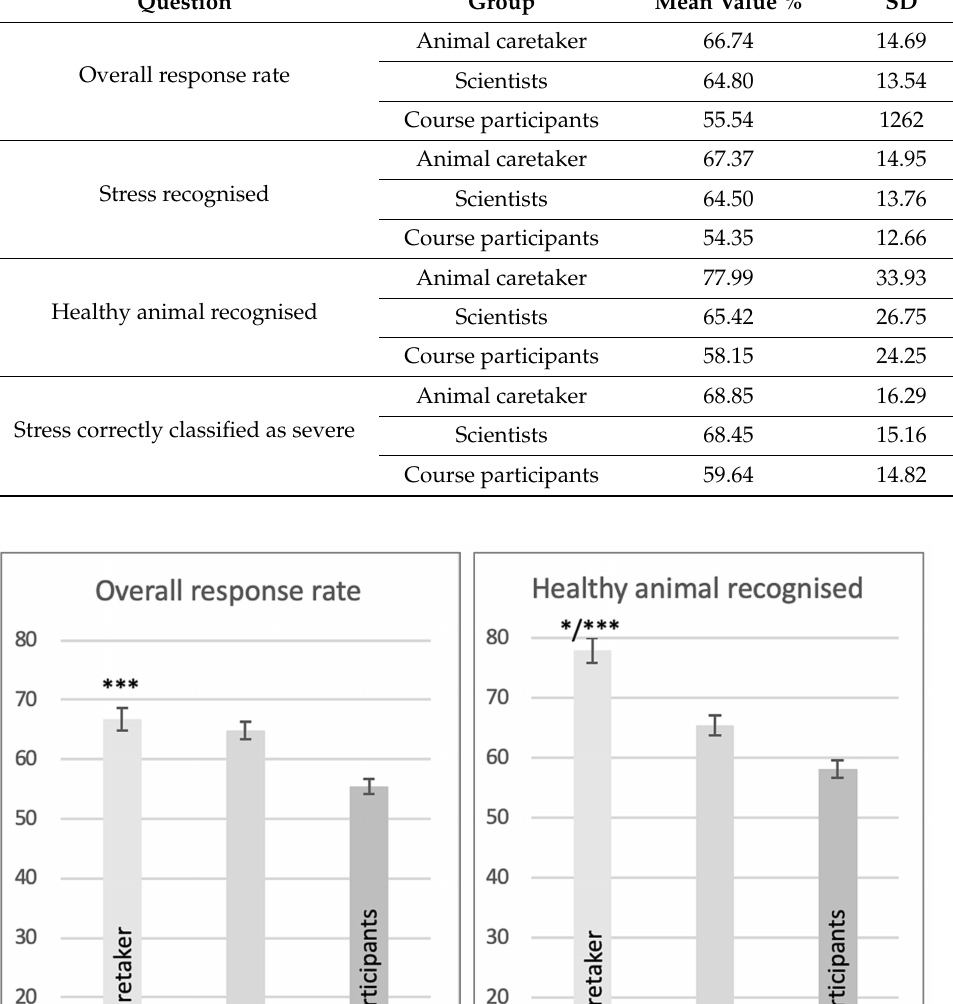
Table 2. Responses to images and video material of healthy and distressed animals compared for the different groups. SD = standard deviation. The animal caretakers gave the most correct answers to all questions. The most obvious differences are in the questions recognising healthy animals and severe magnitude of stress.